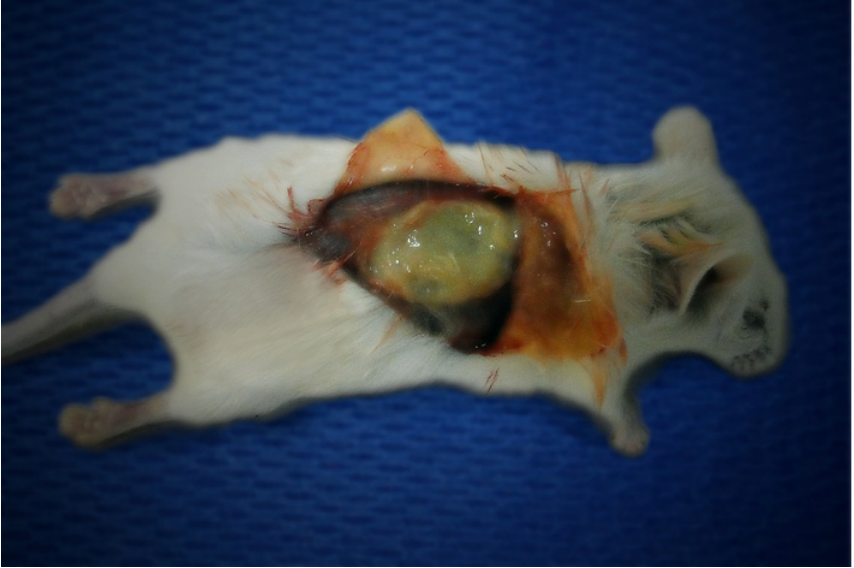
Fig 1. Subcutaneous air-pouch. Clinical appearance of the air-pouch on the dorsum of the mouse after skin flap procedure.